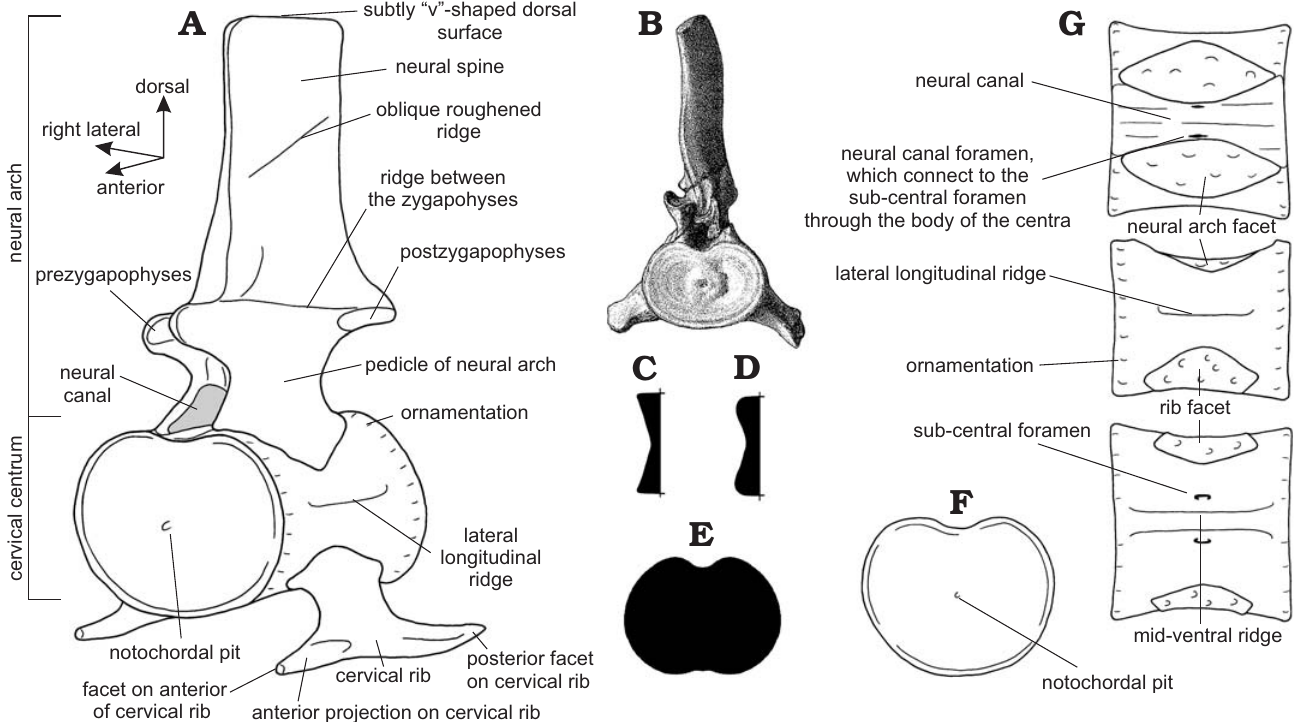
Fig. 7. Cervical vertebrae and cervical centra of plesiosaurs. A . Generalized plesiosaur cervical vertebra showing features mentioned in the text in oblique antero-left lateral view (note: not all features are present in all species). B . Posterior cervical vertebra of Muraenosaurus beloclis illustrating the form as preserved in anterior view (note the wider than high form of the centrum, typical of all plesiosaurs). Illustrative vertical cross-sections through the articular surfaces (to the left) of Muraenosaurus ( C ) and Cryptoclidus ( D ), showing variation in cross-sectional shape between genera, which may have affected the range of movement available at contiguous cervical joints (data from Brown 1981b). E . Illustrative articular face of a Cretaceous elasmosaur cervical vertebra, showing the laterally expanded butterfly- or dumbbell-shape. F – I . Views of a generalized plesiosaur cervical centrum (anterior face to the left), showing fea- tures mentioned in the text, in anterior ( F ), dorsal ( G ), left lateral ( H ), and ventral ( I ) views. Images from: B, Andrews (1910: pl. 7: 4); A, C–I, LFN